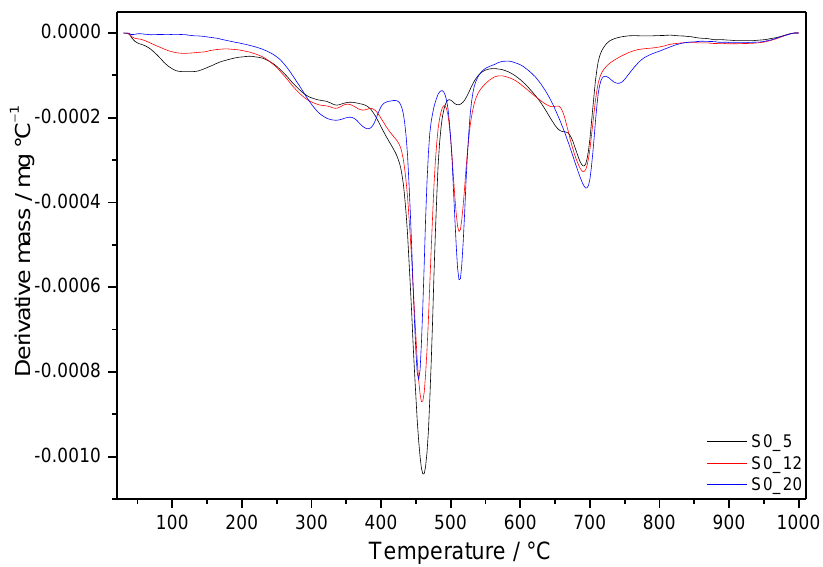
Figure 6. DTG curves of samples without SF addition after 7 days of hydrothermal curing.